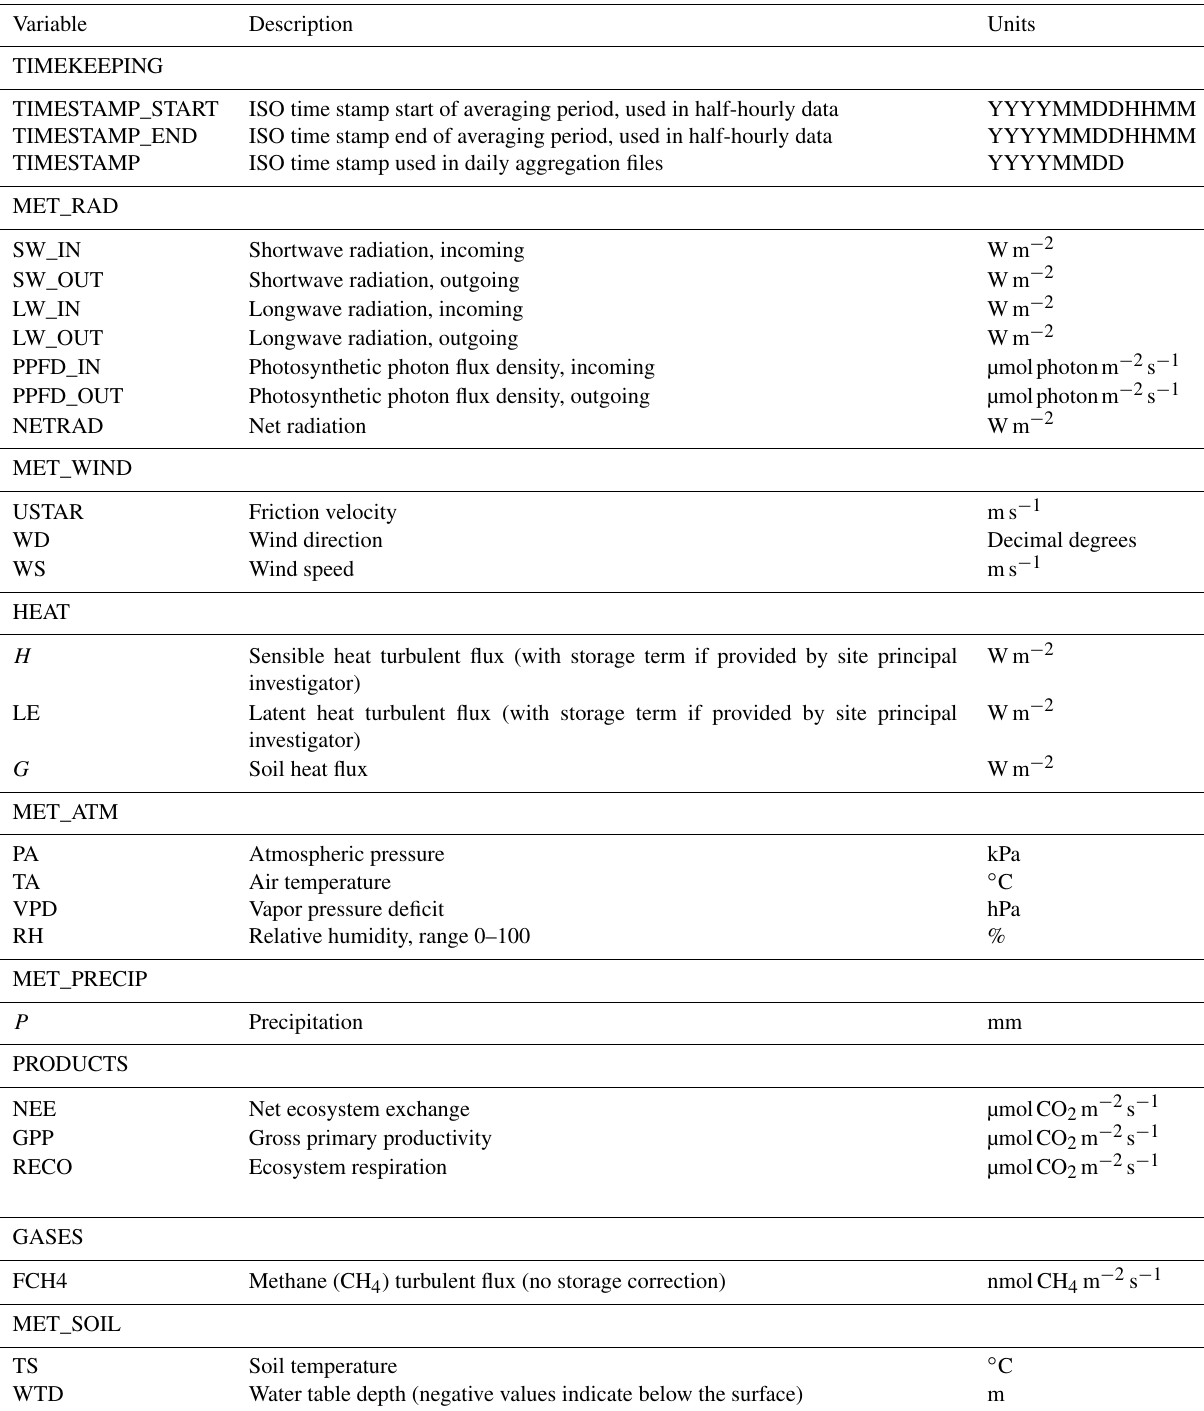
Water table depth (negative values indicate below the surface)